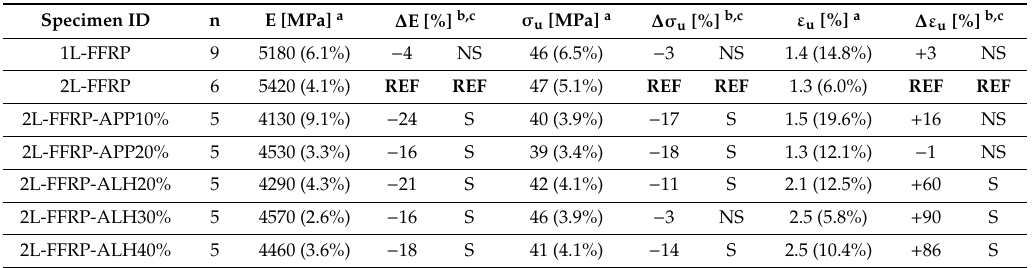
Table 6. The results of the mechanical test under tension